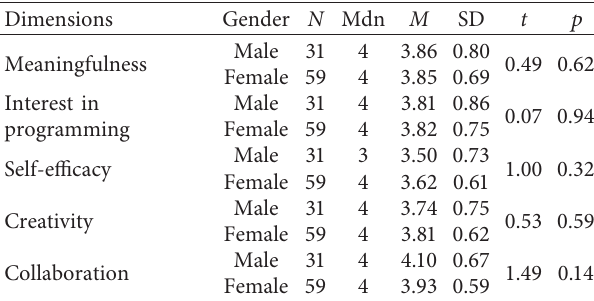
Table 5: Independent samples t -test comparing gender differences in dimensions of attitude toward